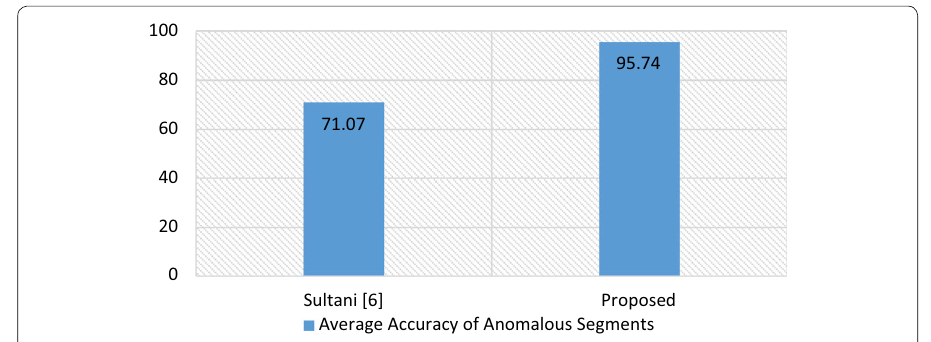
Fig. 11 Average comparisons of accuracies in UCF-Crime dataset